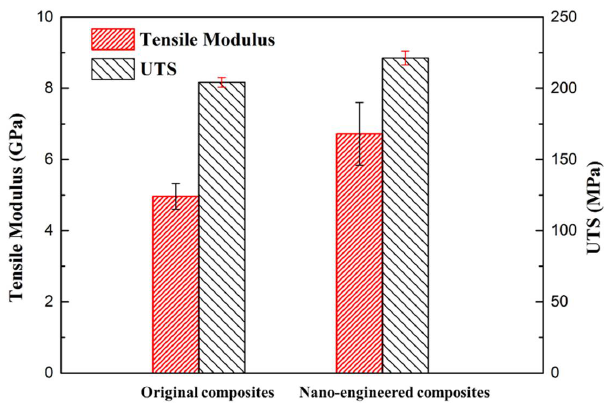
Figure 8. Mechanical properties of the original composite and nano-engineered composite.